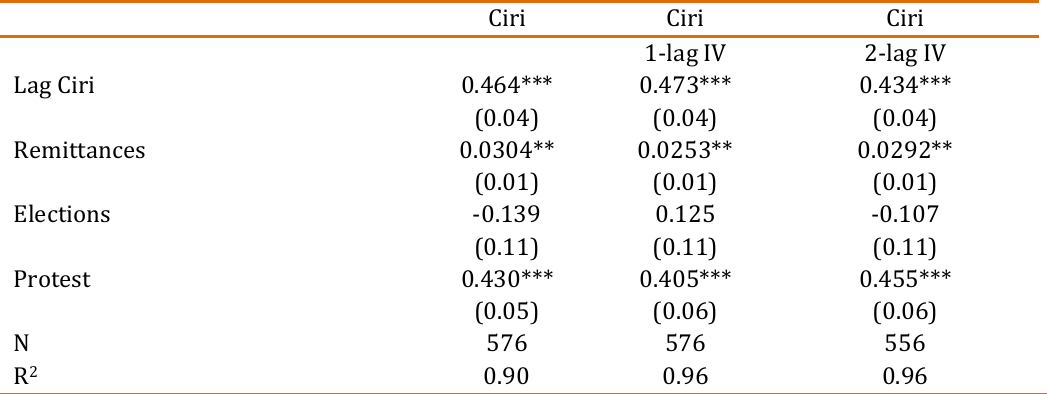
Table 05. Effect of remittances on the level of violations of rights to physical integrity, GMM two- step